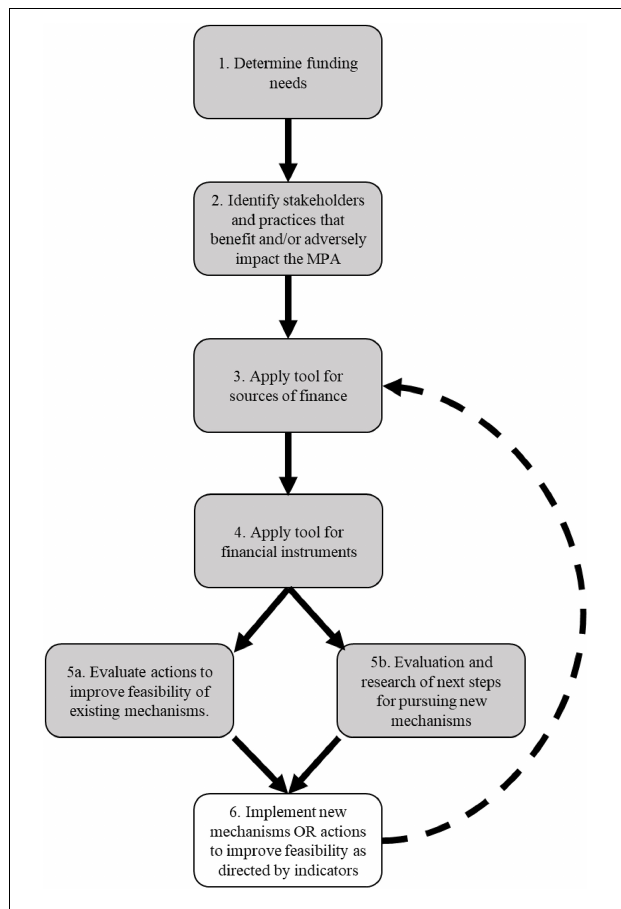
FIGURE 3 | Logical steps for using the excel tool for evaluating mechanisms and management actions that may follow. Shaded boxes were performed for the case example PNN